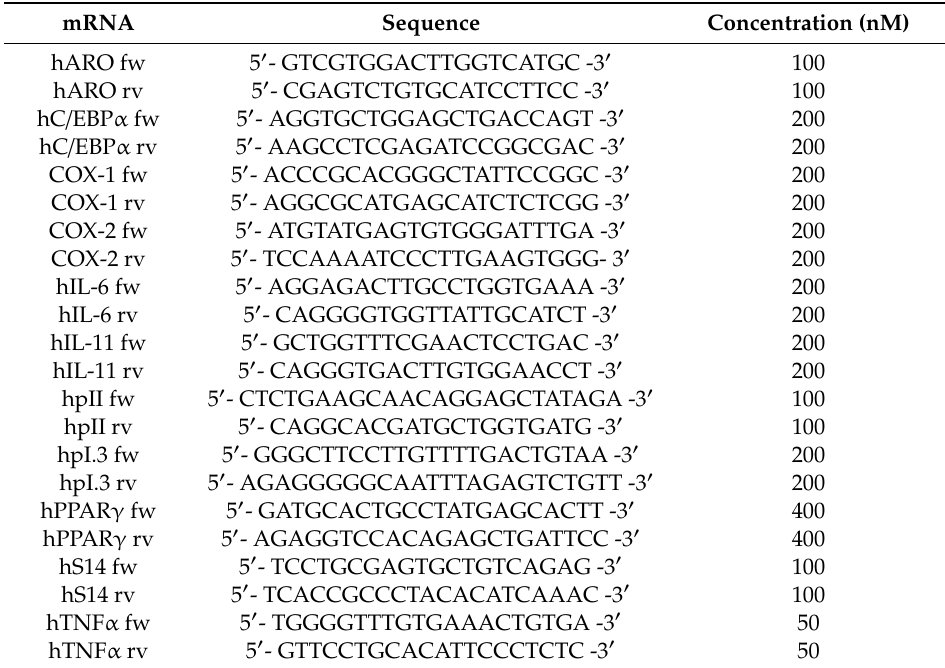
Table 1. Primers used for amplification of mRNA